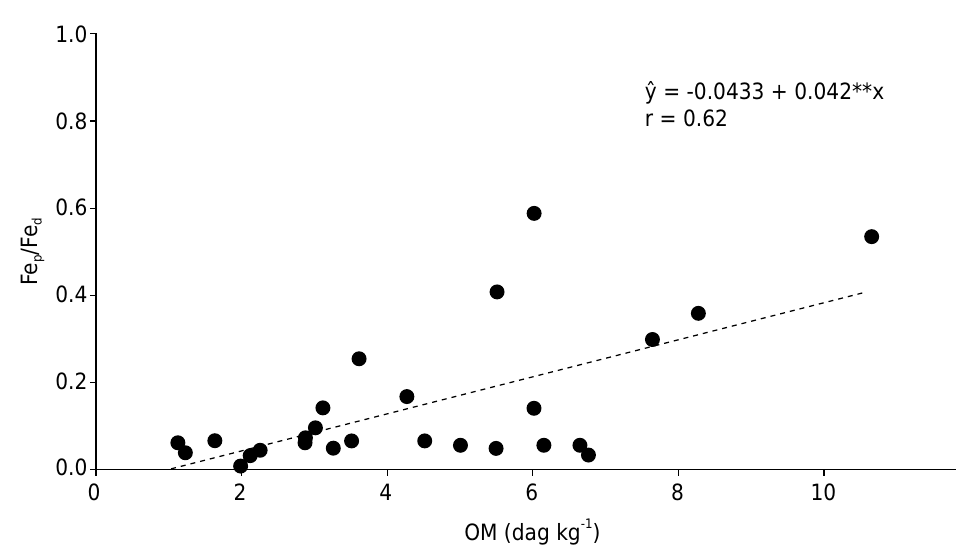
Figure 3. Ratio between the Fe-pyrophosphate (Fe p ) and Fe-dithionite-citrate (Fe d ) fractions and organic matter content of the soils. ** : significant at 1 % by the F test.